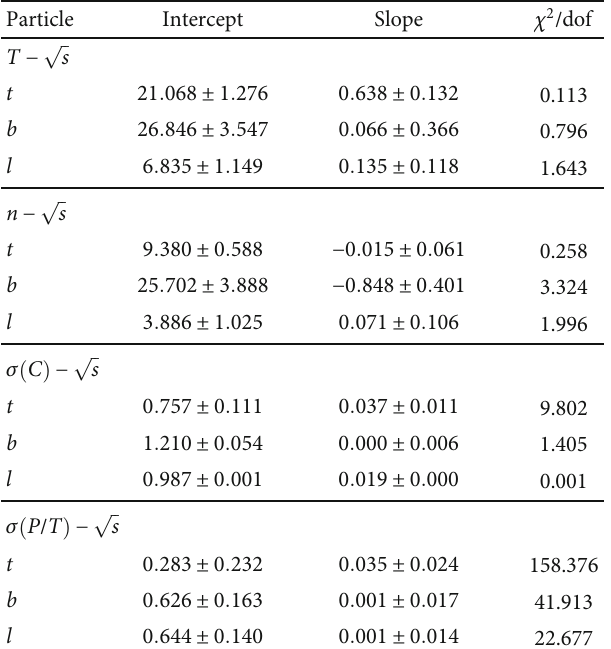
Table 4: Values of intercepts, slopes, and χ 2 /dof corresponding to the lines in Figure 17. Particle Intercept